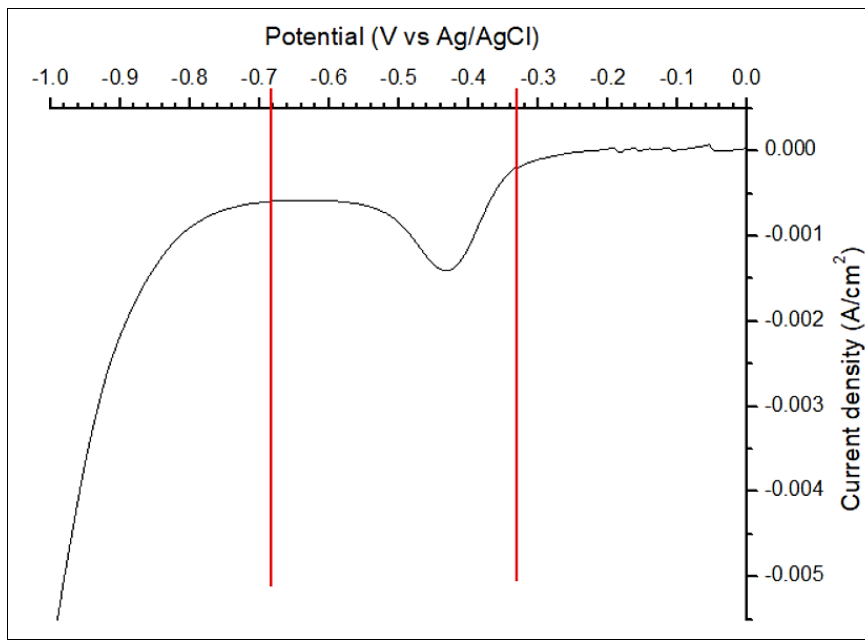
Figure 1. CV graph of Cu 2 O growth on TiO 2 nanorods